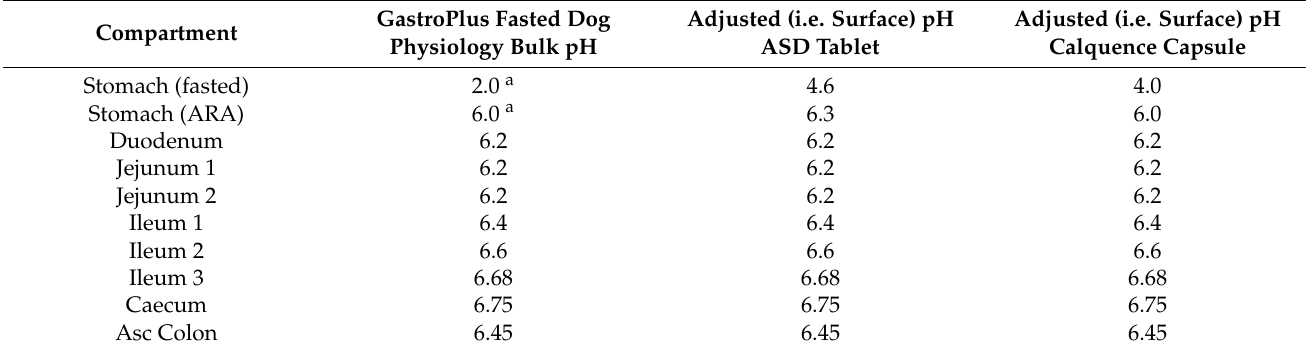
Table A8. GastroPlus fasted dog physiology bulk pH values and adjusted surface pH values used in the in silico simulations for ASD tablet and Calquence